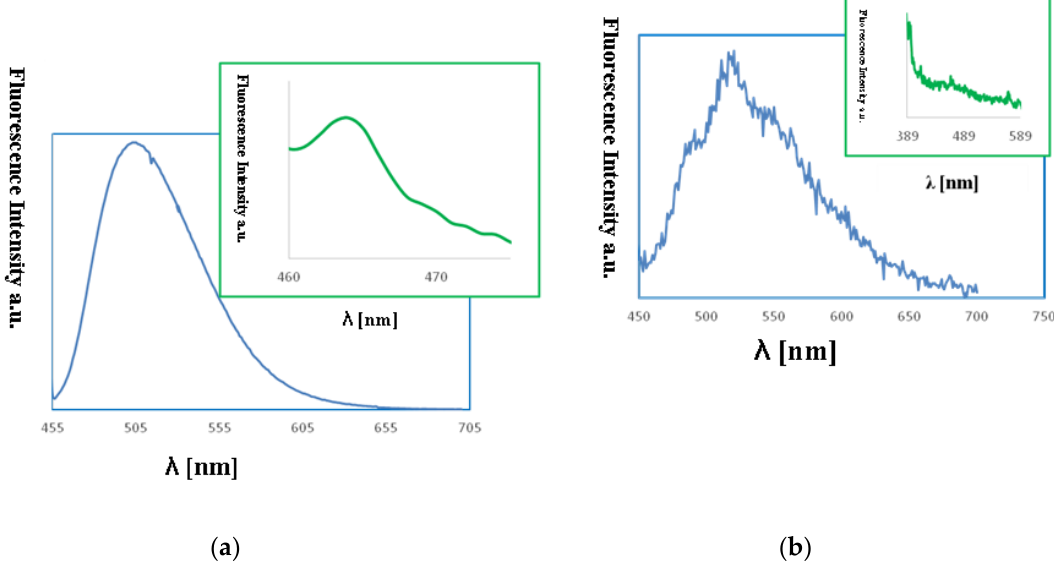
Figure 14. Fluorescence spectra of ( a ) {[Cu 2 (L1)Cl 2 ] 2 [CuCl 4 ]} · 2MeCN · 2H 2 O ( 1 ), MeCN, λ em = 509 nm blue lines ( b ) {[Cu 2 (L1)Cl 2 ] 2 [CuCl 4 ]} · 2MeCN · 2H 2 O, PMMA / Si λ ex = 450 nm, λ em = 464 nm, green lines ( a ): [Cu 2 (L2)Cl 3 ] · 0.5MeCN ( 2 ), MeCN, λ ex = 440 nm, λ em = 520 nm, ( b ) [Cu 2 (L2)Cl 3 ] · 0.5MeCN, PMMA / Si, λ ex = 380 nm, λ em = 460 nm.